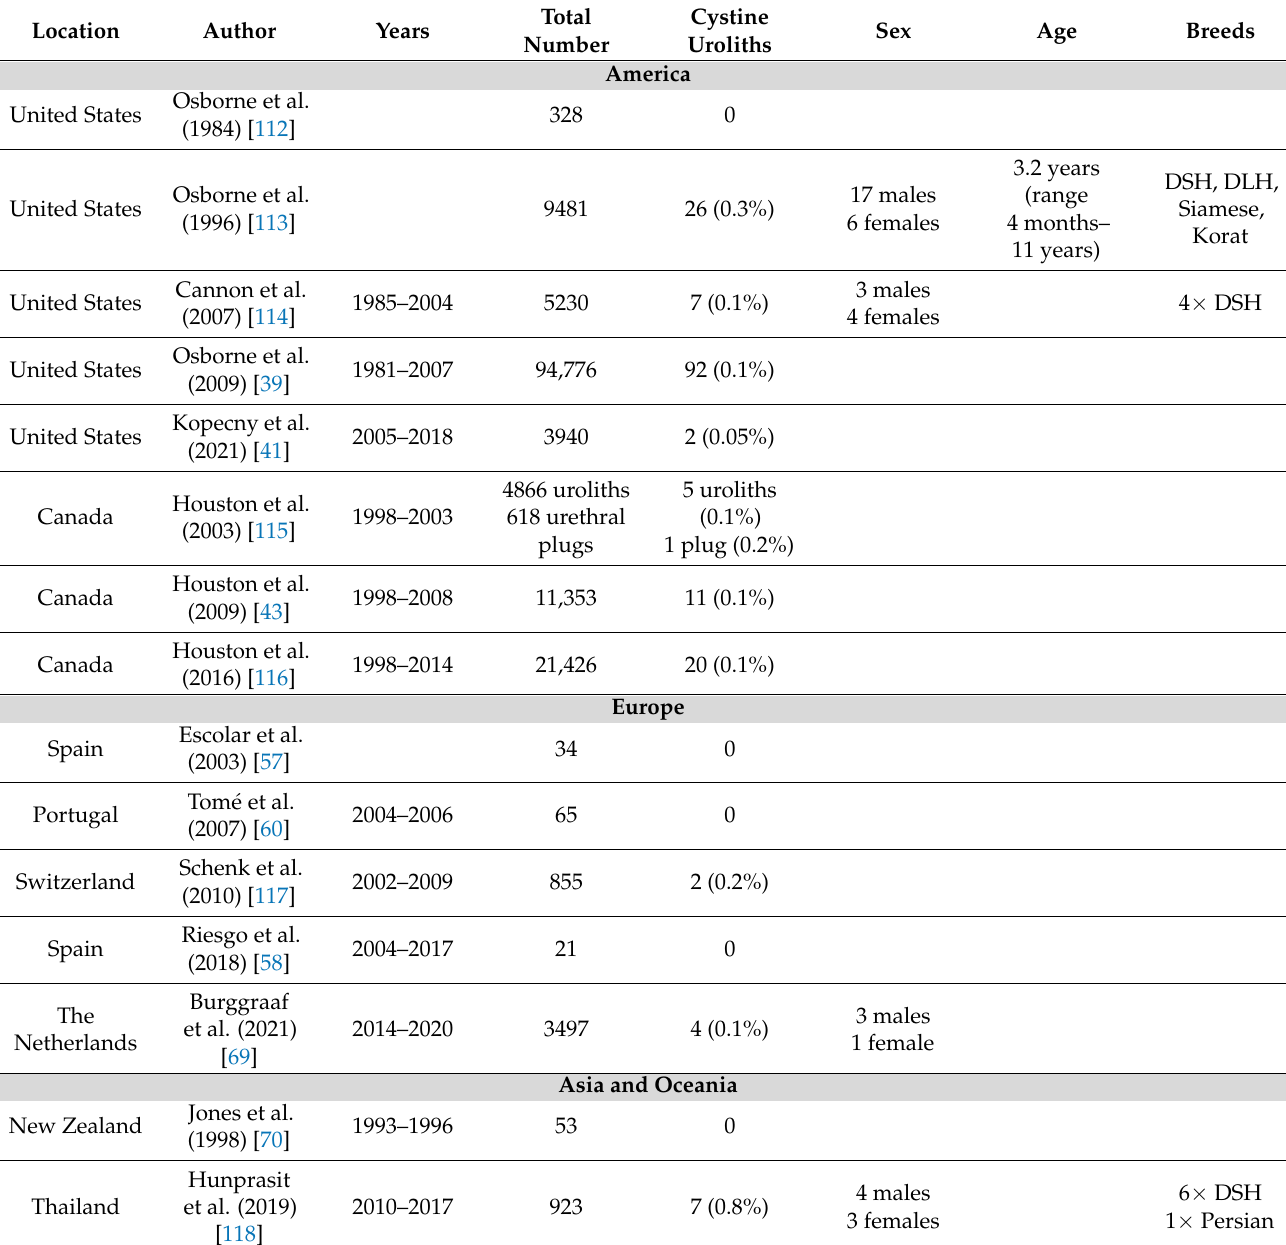
Table 4. Prevalence of cystine urolithiasis in cats by region and characteristics of affected cats in various studies.